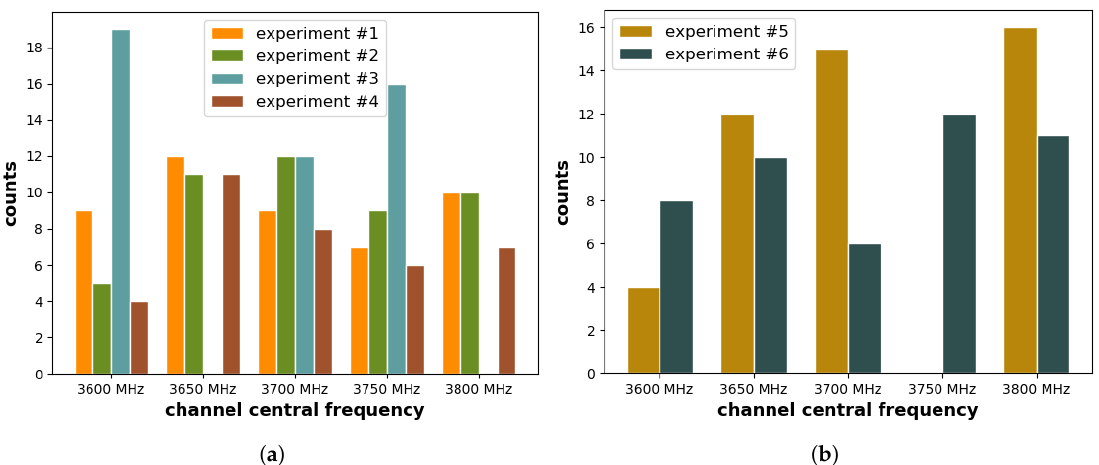
Figure 6. Channels utilized for transmissions in a 4-node full-mesh topology in IRIS: ( a ) PU absence. ( b ) PU